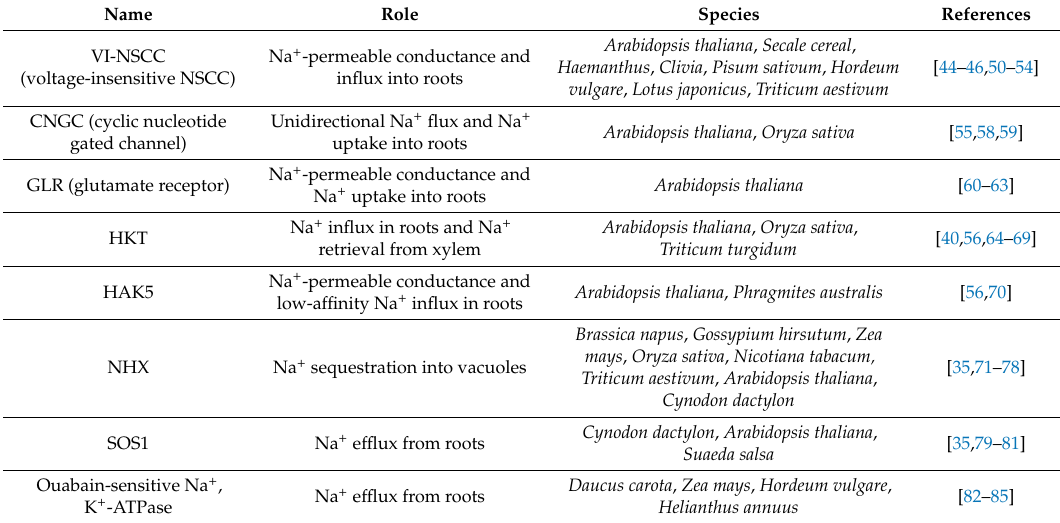
Table 1. Role of various types of ion channels and transporters involved in sodium transport in